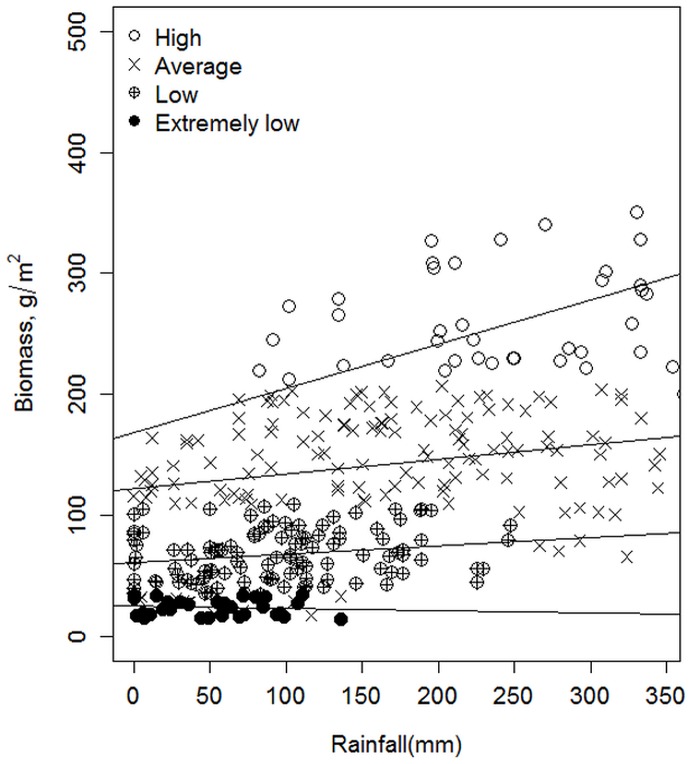
The grass biomass produced per unit of rainfall classified by high, average, low and extremely low biomass deviations from the mean.The growth for a given level of rainfall reflects the starting biomass level. Periods of low and extremely low biomass produce far less growth for the same level of rainfall compared to average and high biomass periods. An Analysis of Covariance (ANCOVA) to compare the four regression lines above shows that their slopes are significantly different (F = 7.01, p = 0.0001).